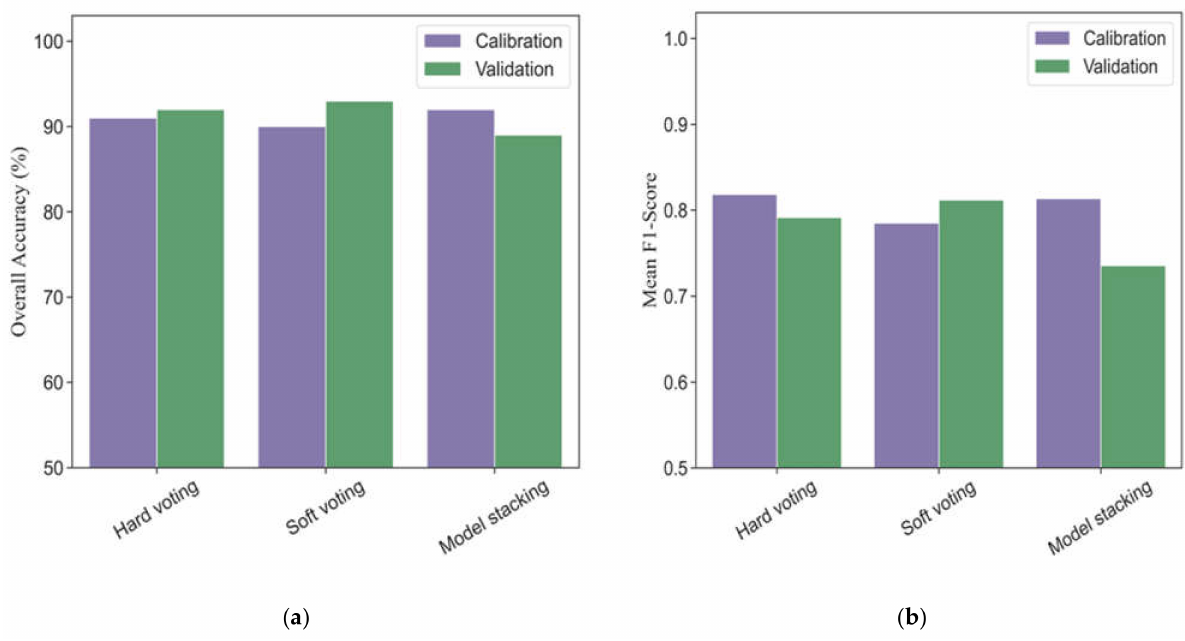
Figure 6. The overall accuracies ( a ) and mean F1-scores ( b ) in different ensemble models for phenological detection in calibration and validation